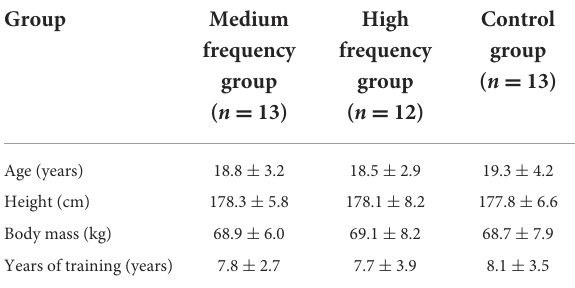
TABLE 1 Basic information of the study